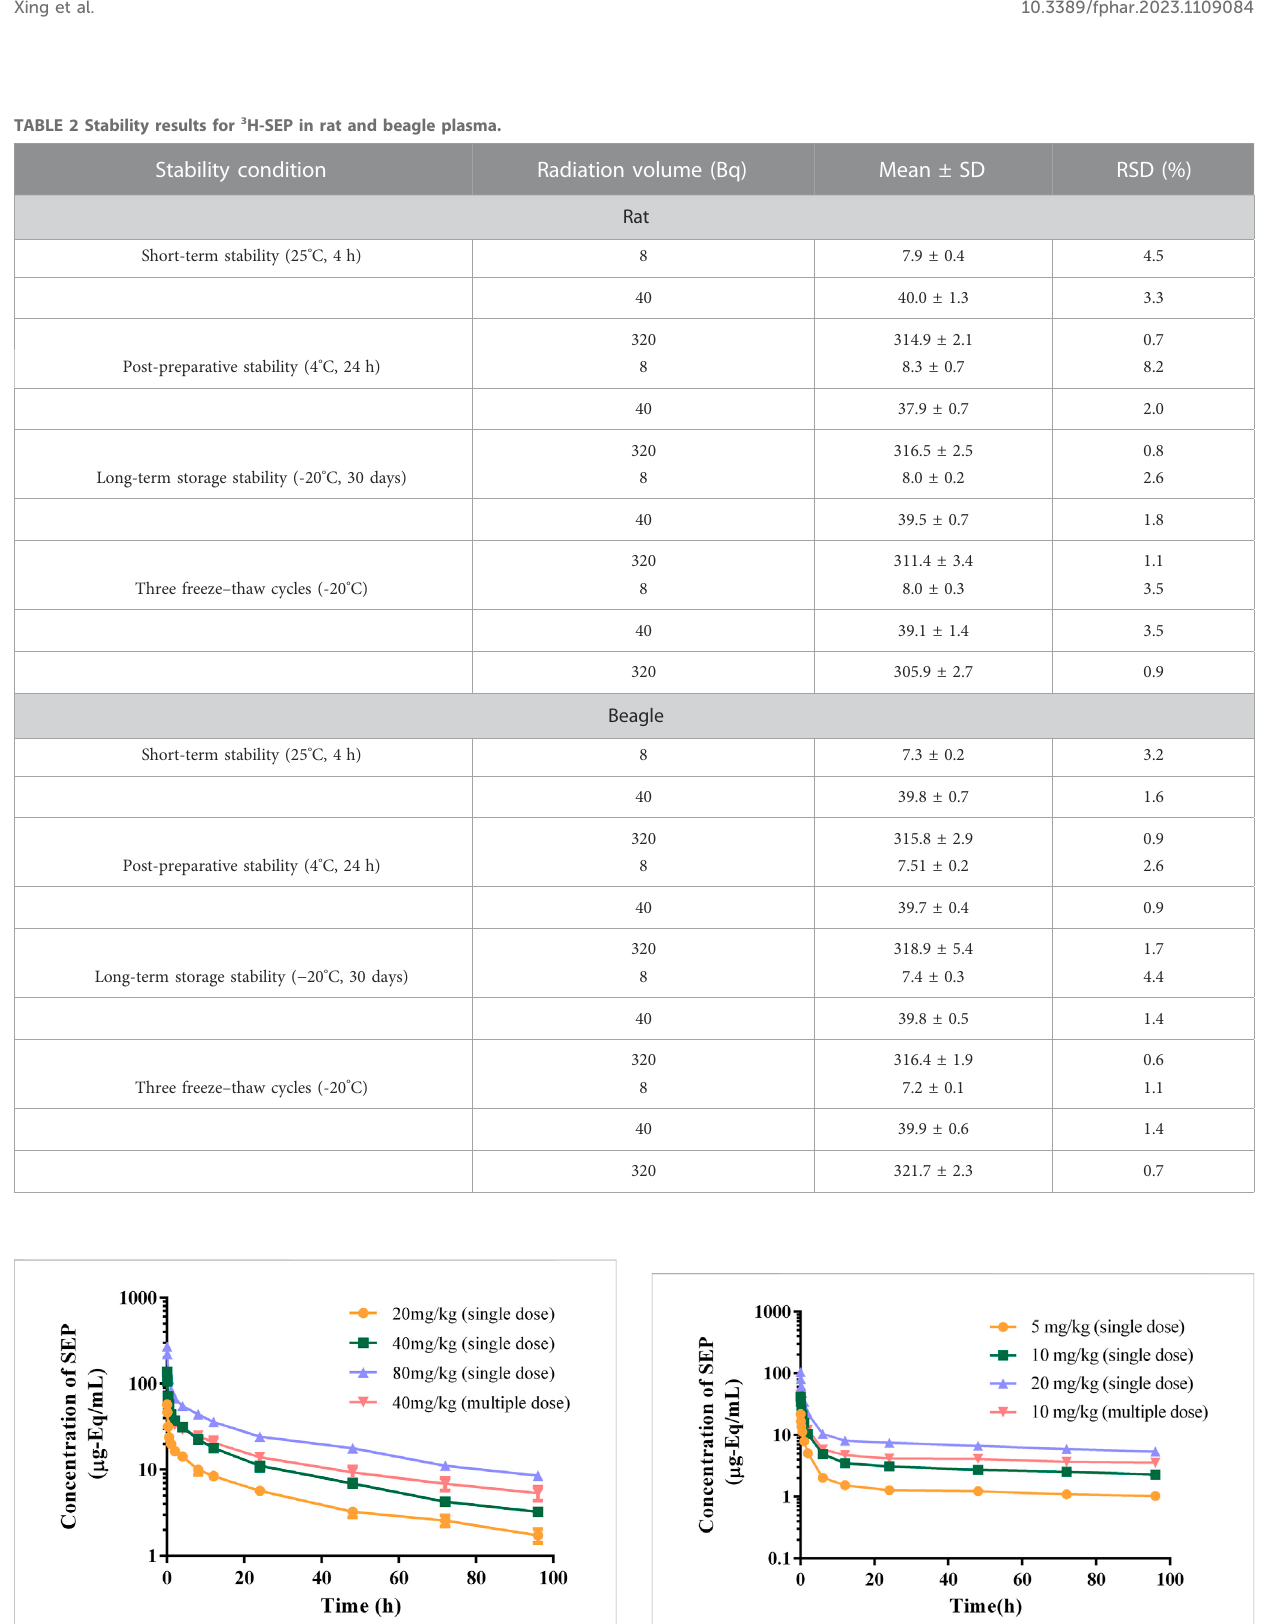
FIGURE 3 Logarithmic graph of mean plasma concentration – time pro fi les in beagles after intravenous injection of SEP (single doses of 5, 10, or 20 mg/kg or multiple doses of 10 mg/kg on the seventh